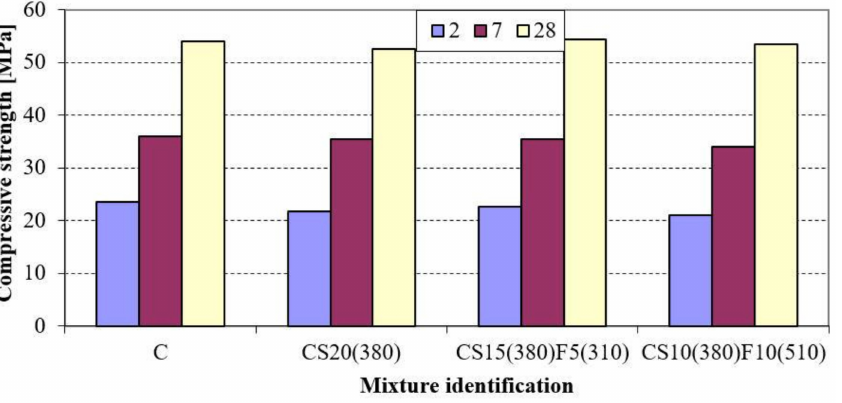
Figure 4. Compressive strength of Portland